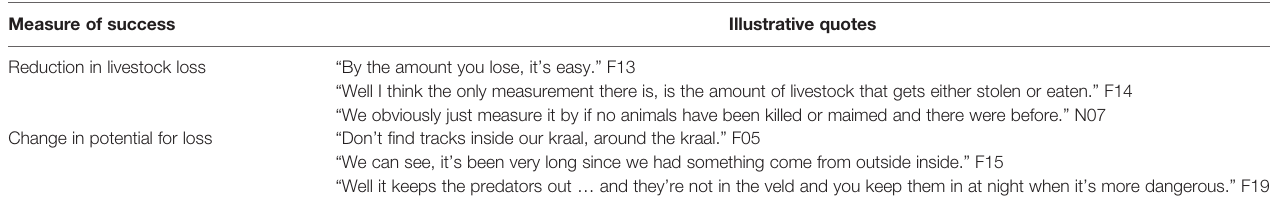
TABLE 2 | Stakeholder measures of intervention strategy success emerged in two main categories; illustrative quotes are used to describe the categories. Measure of success Illustrative